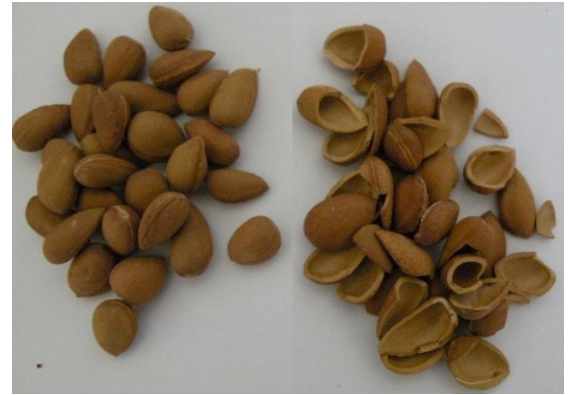
Figure 1. Photograph of the raw material